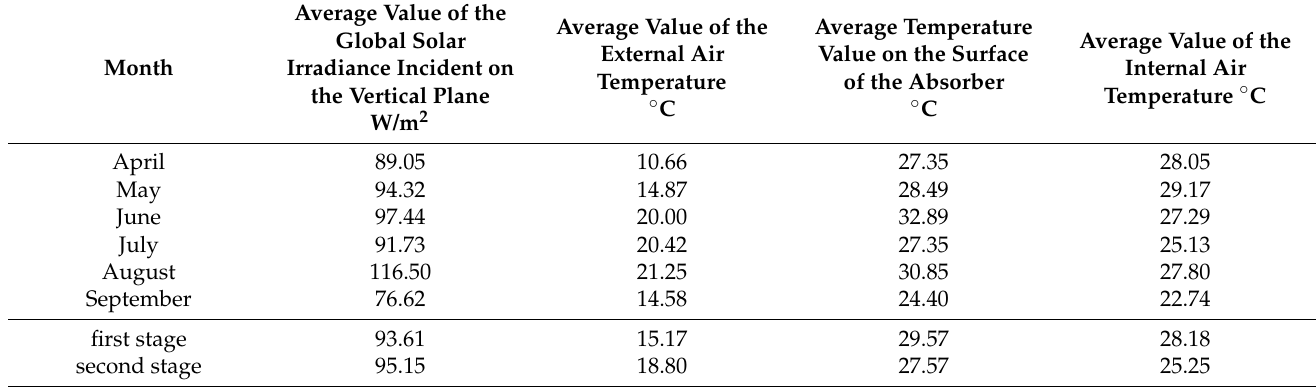
Table 4. Tabular summary of results for the summer period.